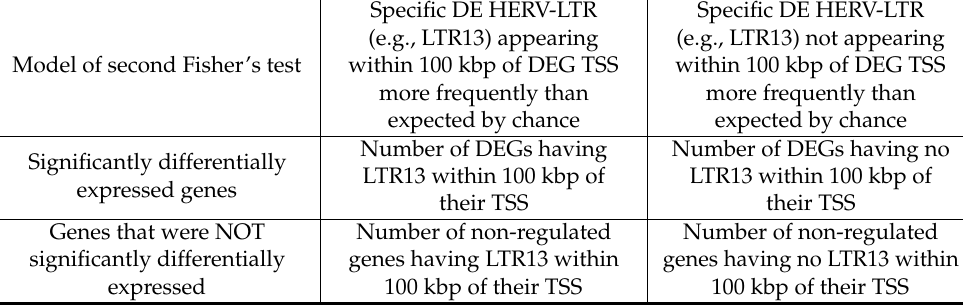
Specific DE HERV-LTR more frequently than more frequently than expected by chance expected by chance Number of DEGs having LTR13 within 100 kbp of their TSS